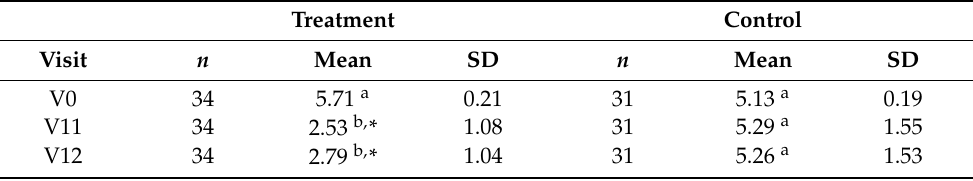
Table 4. DN4 questionnaire total scores.